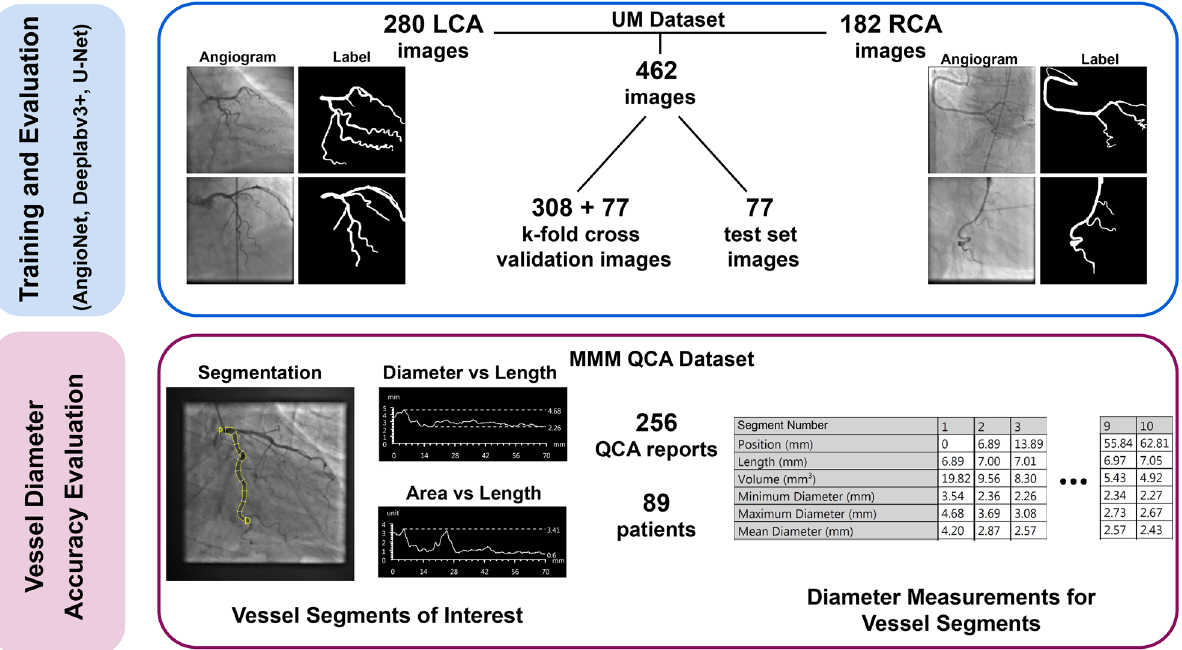
Figure 1. Diagram of datasets for CNN training and evaluation. AngioNet’s performance was compared against state-of-the-art neural networks, all trained on the UM Dataset. The MMM QCA dataset was used to quantify segmentation diameter accuracy by comparing AngioNet’s results against the diameters reported in QCA. Left coronary artery (LCA); right coronary artery (RCA); Madras Medical Mission